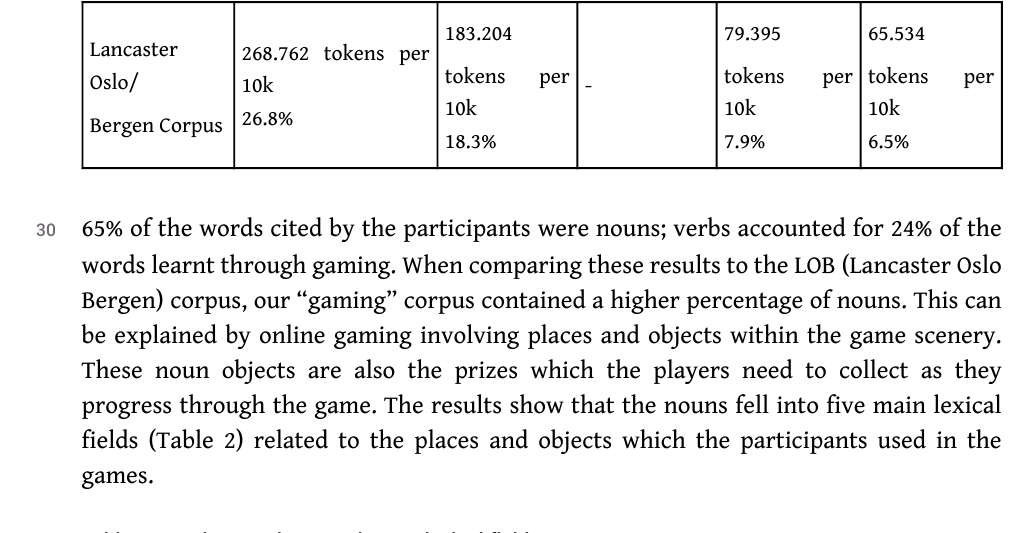
Table 2: Gaming word categories per lexical field